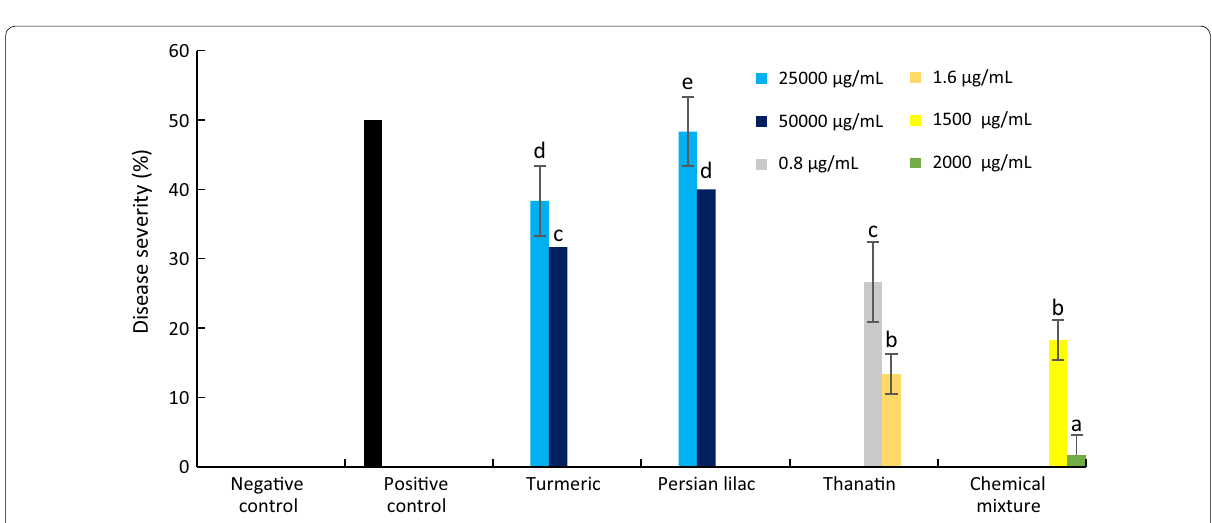
Fig. 8 Severity of early blight disease evaluated on different pretreated tomato plants 15 days after inoculation by A.